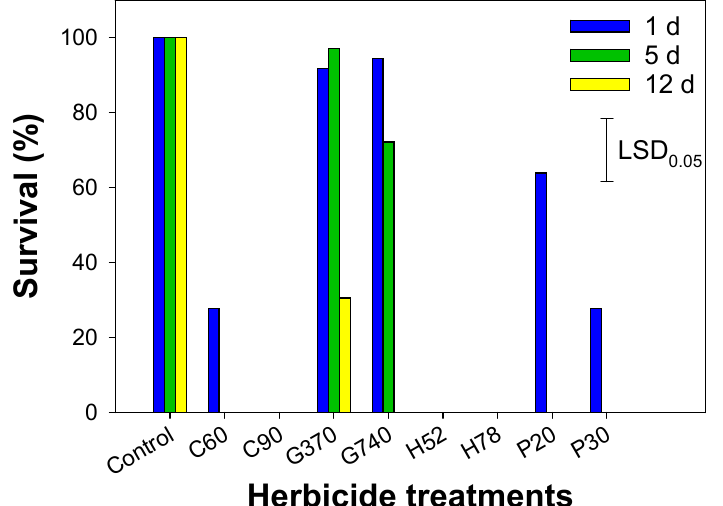
Figure 1. The interaction effect of herbicide (nontreated control; C60, clethodim 60 g a.i. ha − 1 ; C90, clethodim 90 g a.i. ha − 1 ; G370, glyphosate 370 g a.e. ha − 1 ; G740. Glyphosate 740 g a.e. ha − 1 ; H52, haloxyfop 52 g a.i. ha − 1 ; H78, haloxyfop 78 g a.i. ha − 1 ; P20, pinoxaden 20 g a.i. ha − 1 ; and P30, pinoxaden 30 g a.i. ha − 1 ) and their application timing (1, 5, and 12 d after grazing) on the survival (%) of Avena fatua .